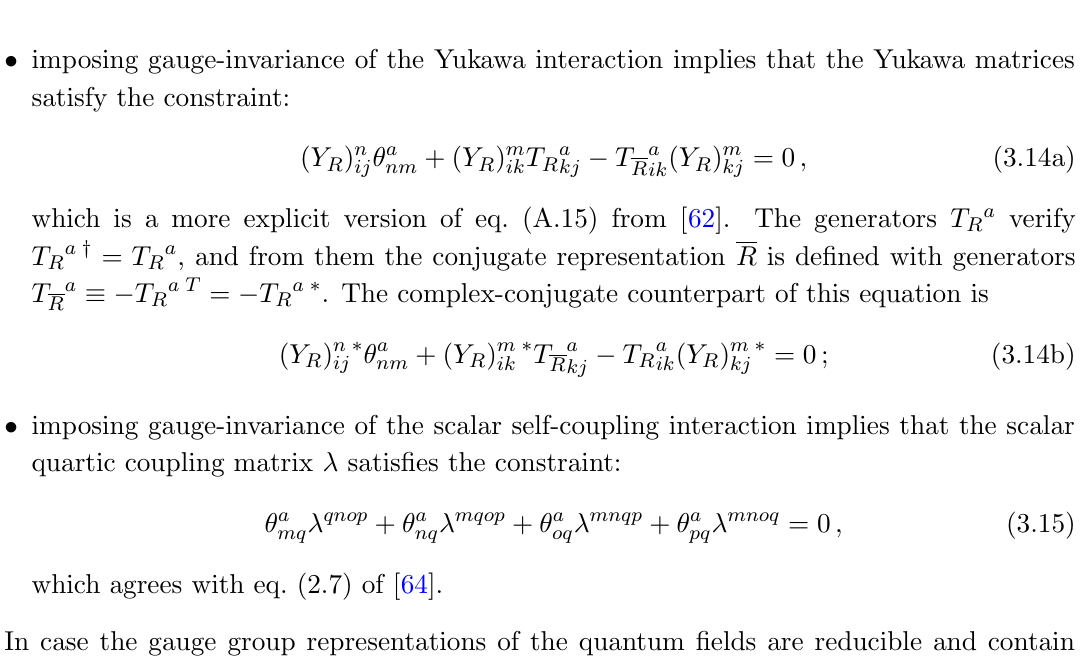
imposing gauge-invariance of the scalar self-coupling interaction implies that the scalar (cid:15) quartic coupling matrix (cid:21) satis(cid:12)es the